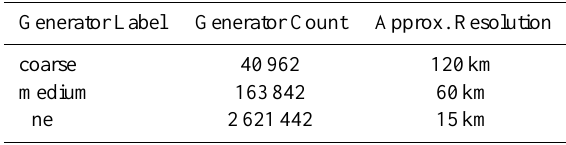
Table 1. Description of generator count labels, along with approxi- mate grid resolution on an earth sized